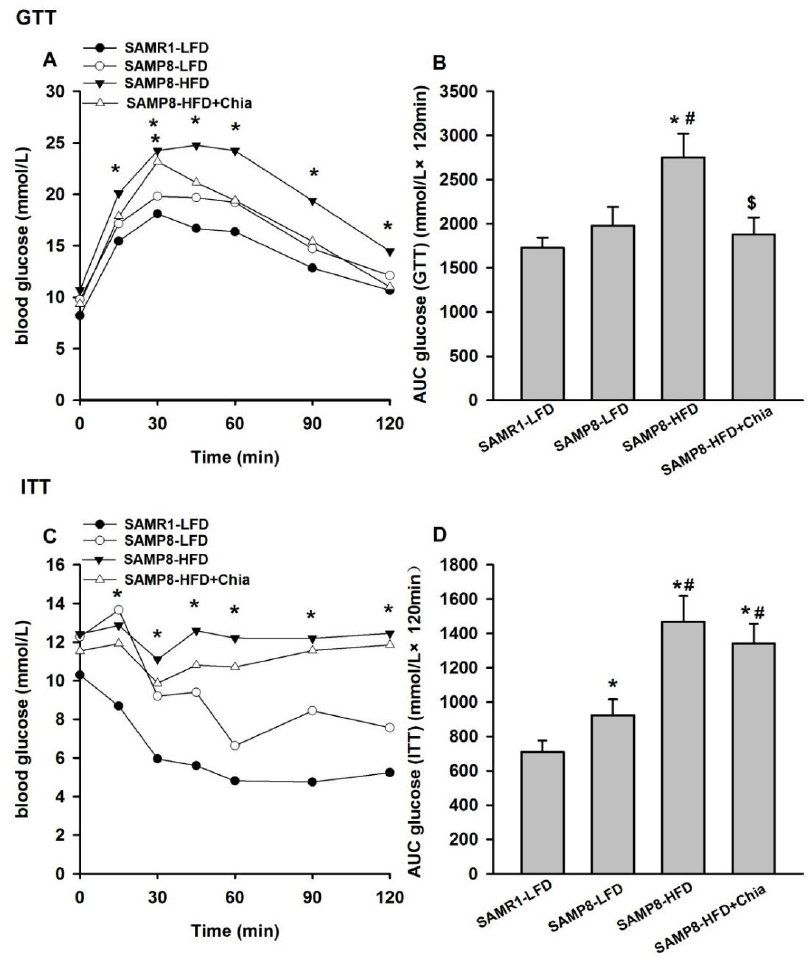
Figure 2. Intraperitoneal glucose (GTT) and insulin tolerance tests (ITT) of mice from different groups. Glucose levels ( A ) at different timepoints and total area under the curve (AUC); ( B ) post-glucose injection. Glucose levels ( C ) at different timepoints; and AUC ( D ) post-insulin injection. Data are presented as means + SEM for 8 mice per group.* p < 0.05 versus SAMR1-LFD group within the same timepoint in ( A , C ). * p < 0.05 versus SAMR1-LFD group in ( B , D ); # p < 0.05 versus SAMP8-LFD group in ( B , D ); $ p < 0.05 versus SAMP8-HFD group in (B